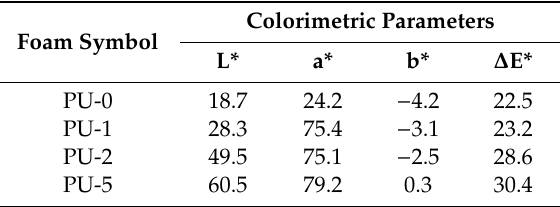
Table 8. Color analysis of PU foams after UV aging.